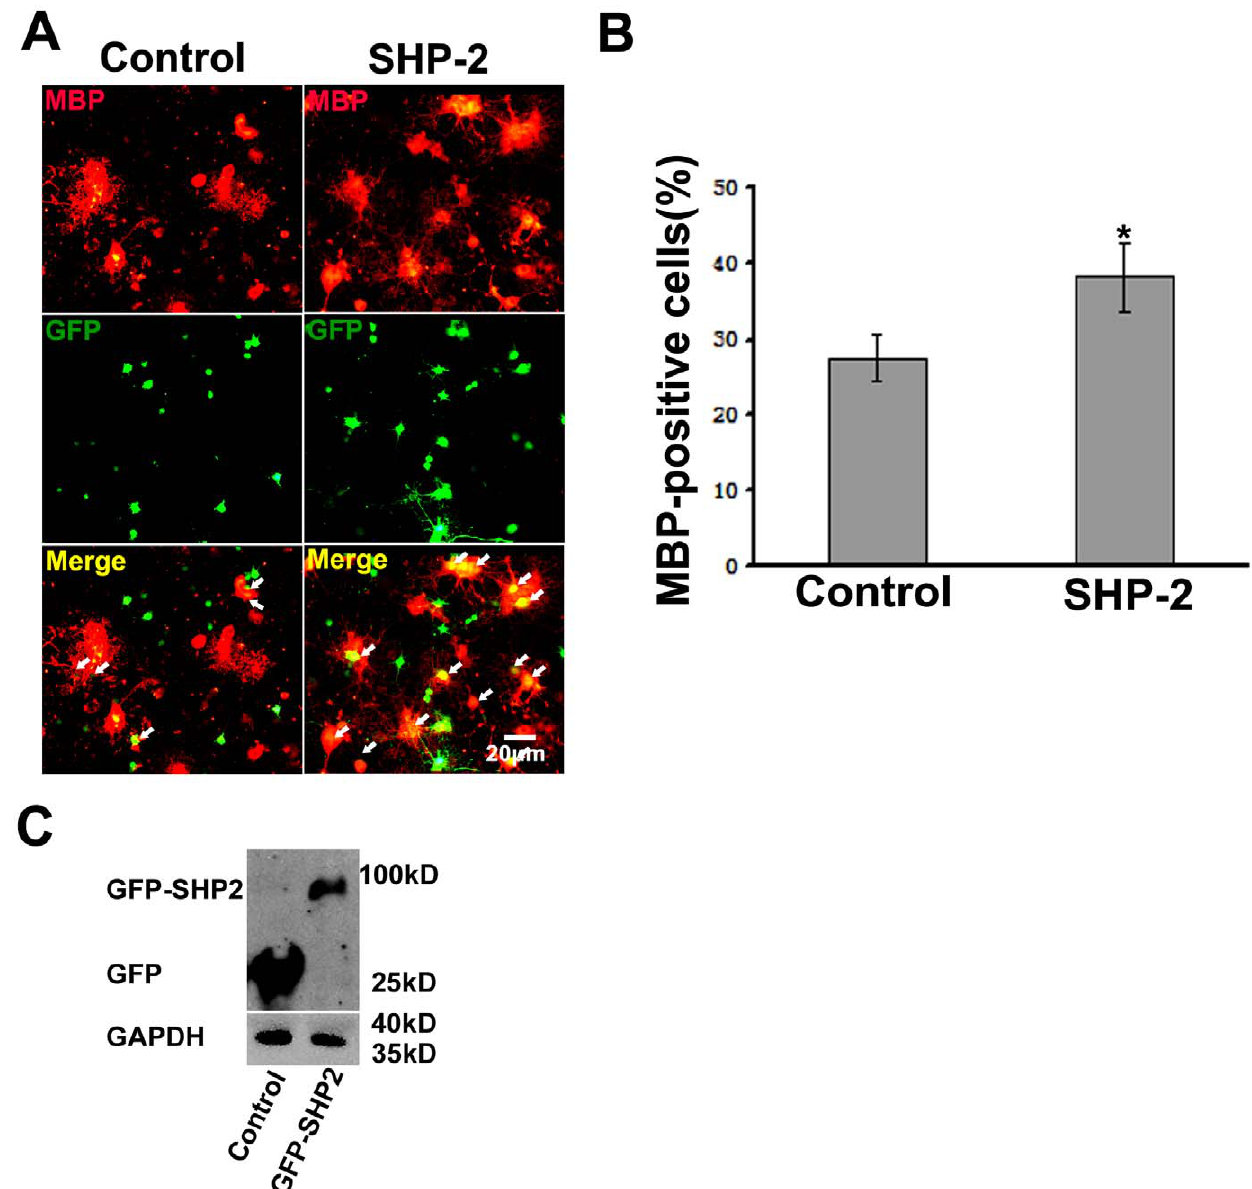
Figure 8. Overexpression of SHP-2 positively regulates oligodendrocyte maturation. ( A ) OPCs were infected with lentivirus expressing SHP-2. After induction of maturation for 3 days, cells were immunostained with anti-MBP antibody (red). Arrows indicate MBP + in GFP-expressing cells. The cells infected with Lentivirus expressing the blank vector tagged by GFP were used as control. ( B ) Percentages of MBP-positive cells (red) against the total number of infected cells, over 500 cells were analyzed for each group. Data represent three independent experiments. * p , 0.05. ( C ) The overexpression of GFP-SHP2 in transfected OPCs were detected by western blot using GFP antibody.